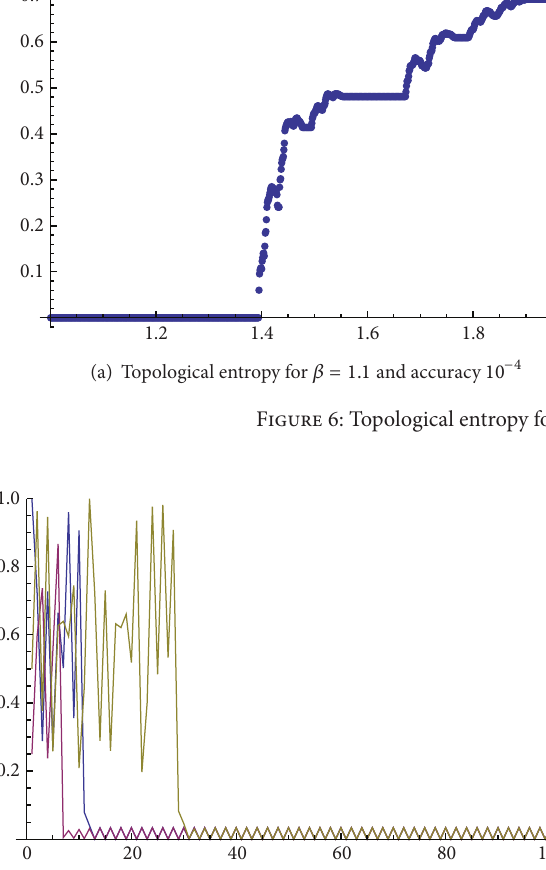
Figure 7: We draw a sample of 100 points of three orbits with initial values 0.25 , 0.5 , and 1 when the parameter values are 𝛼 = 1.8 and 𝛽 = 1.85 . The picture shows the convergence to a two-periodic orbit which maps 0.033582 to 0.000140067 and vice